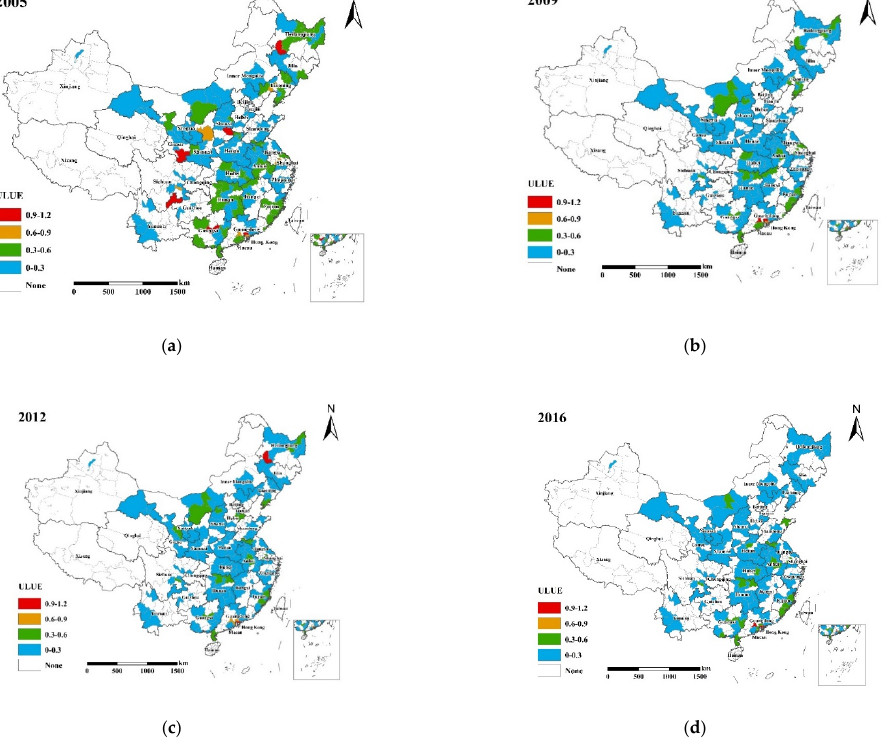
Figure 4. The spatial distribution diagram of urban land use efficiency. ( a ) The spatial distribution diagram of urban land use efficiency in 2005. ( b ) The spatial distribution diagram of urban land use efficiency in 2009. ( c ) The spatial distribution diagram of urban land use efficiency in 2012. ( d ) The spatial distribution diagram of urban land use efficiency in 2016.